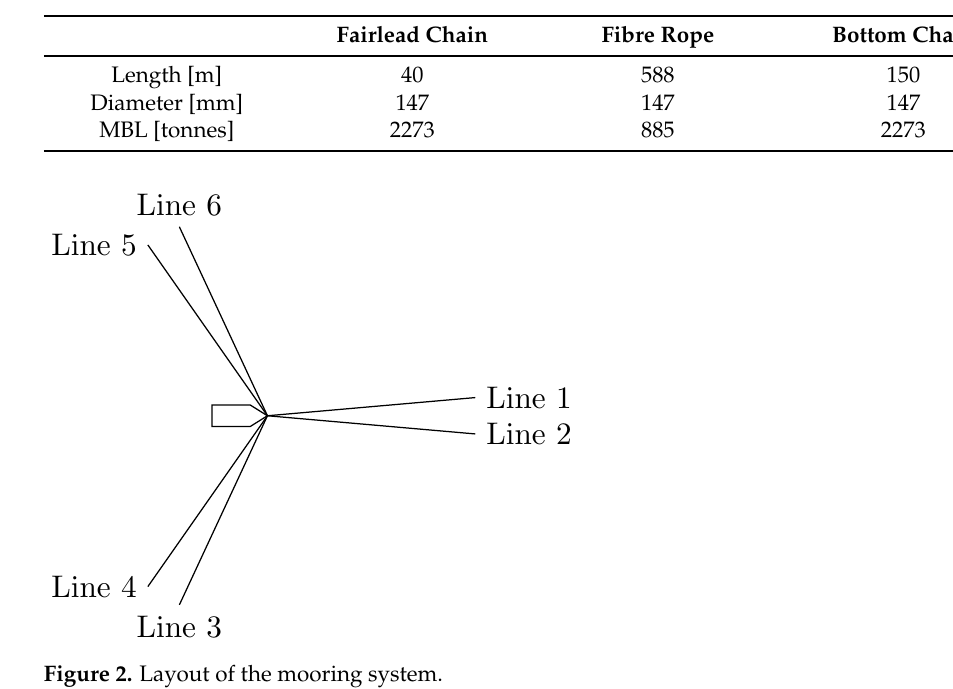
Table 2. Properties of the mooring system.